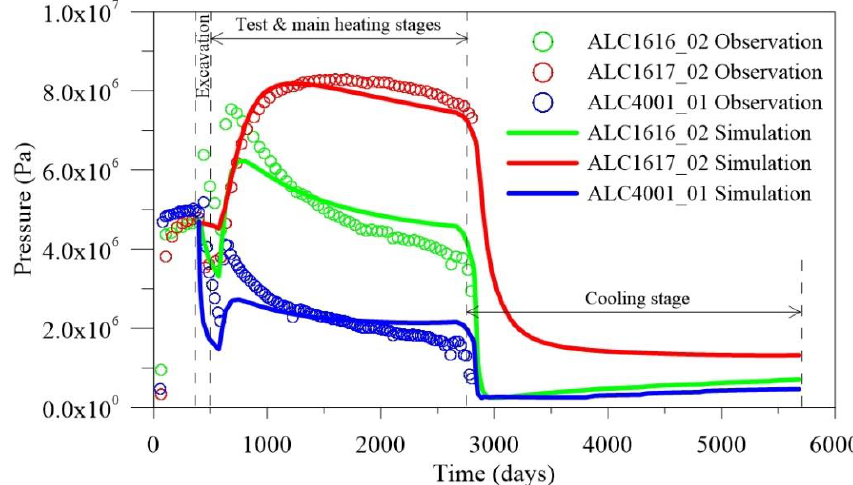
Figure 12. Comparison of pore pressure evolution between the measurements and numerical results at sensors in three monitoring boreholes.